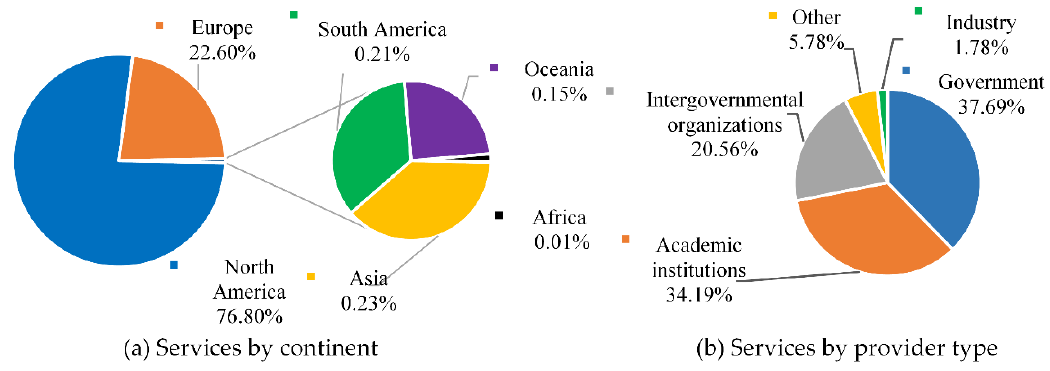
Figure 6. The regional distribution and types of monitored public WMS providers; ( a ) while most services are in North America and Europe, among the remaining 0.6%, Asia contains 0.23%; ( b ) providers by sector; government has the largest proportion (37.69%), followed by academic institutions (34.19%), while industry has the smallest proportion (1.78%).